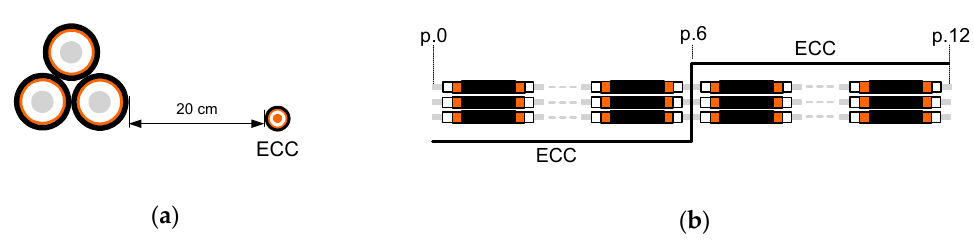
Figure 8. Arrangement of the earth continuity conductor (ECC): ( a ) a distance to the cable line; ( b ) its transposition.